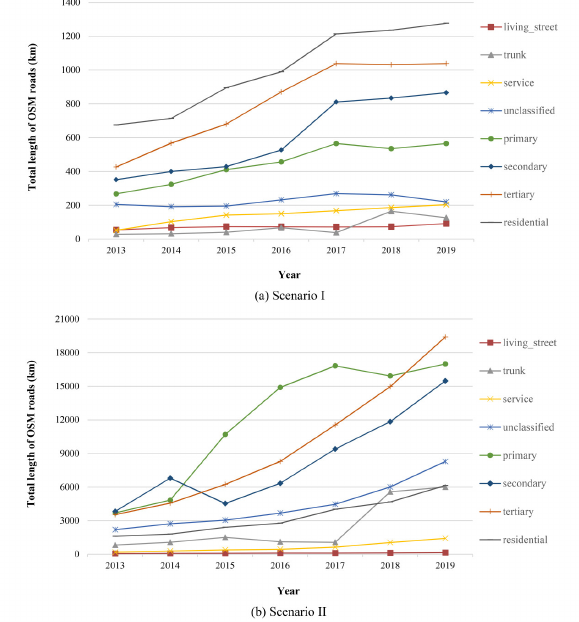
Figure 9. Lengths of OSM roads in Hubei (China) from 2013 to 2019, for eight typical road types. For each year, the corresponding OSM road dataset was acquired in January Figure 9 shows that for the first scenario, the lengths of at least four road types (“Primary”, “Secondary”, “Tertiary”, and “Residential”) increased rapidly from 2013 to 2017, increasing relatively slowly afterwards. This indicates that relatively important OSM roads (e.g. “Primary” and “Secondary”) tend to be complete. For the second scenario, however, a different trend was found, at least for the “Secondary” and “Tertiary” road types. That is, their lengths rapidly increased year-on-year, indicating that these types of OSM road data may not be complete in rural areas, which is consistent with other studies: that is, the OSM data in urban areas were relatively more complete than those in rural areas (Girres and Touya, 2010; Neis et al., 2012). Nevertheless, it is still necessary to investigate the omission of OSM roads in rural areas in future